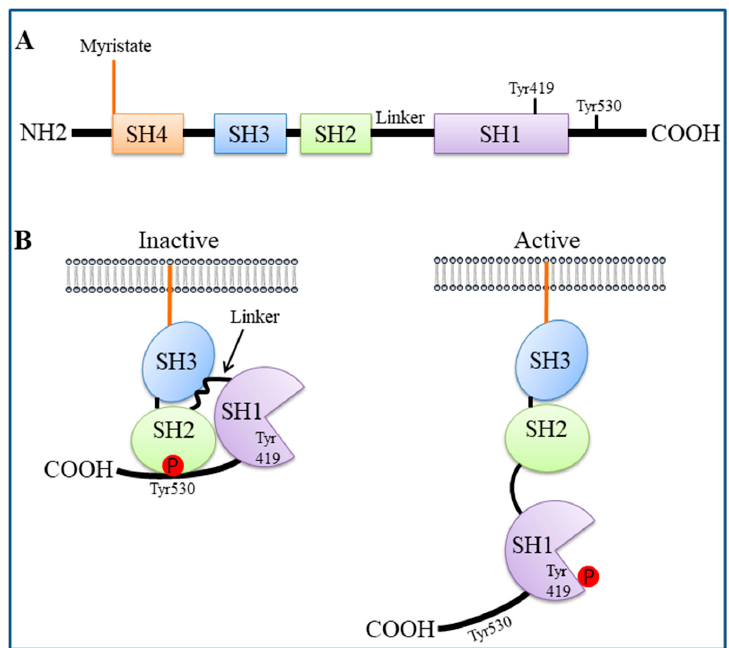
Figure 1. Structure and activation of SRC. ( A ) SRC is composed of four SRC homology (SH) domains: SH4 contains signals for myristoylation for membrane localization; SH3 and SH2 are protein binding regions; SH1 is the tyrosine kinase domain. A linker sequence lies between SH1 and SH2. ( B ) In its inactive form, SRC is phosphorylated in the C-terminal tail at Tyr530 and adopts a closed conformation: the phosphorylated C-terminus binds the SH2 domain and the linker region binds the SH3 domain. Dephosphorylation of Tyr530 causes a conformational change, resulting in autophosphorylation of the kinase domain at Tyr419 and full activation. SFK activity is mainly regulated through phosphorylation/dephosphorylation of the conserved tyrosine residues (Tyr419 and Tyr530 in human SRC) (Figure 1B). In particular, in their inactive form, SFKs are phosphorylated in the C-terminal tail (at Tyr530 of SRC) and adopt a closed conformation through intramolecular interactions (the phosphorylated C-terminus binds the SH2 domain and the